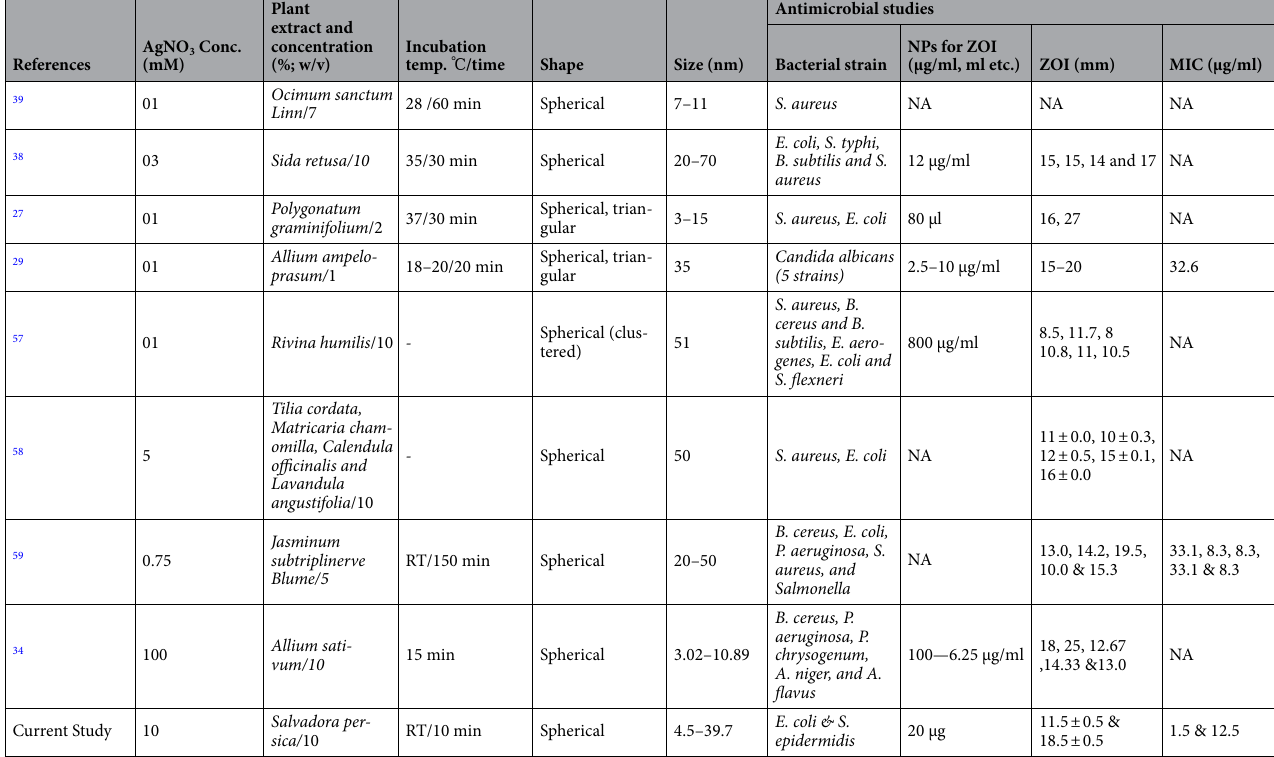
Table 1. Comparison of sunlight mediated AgNPs using plant